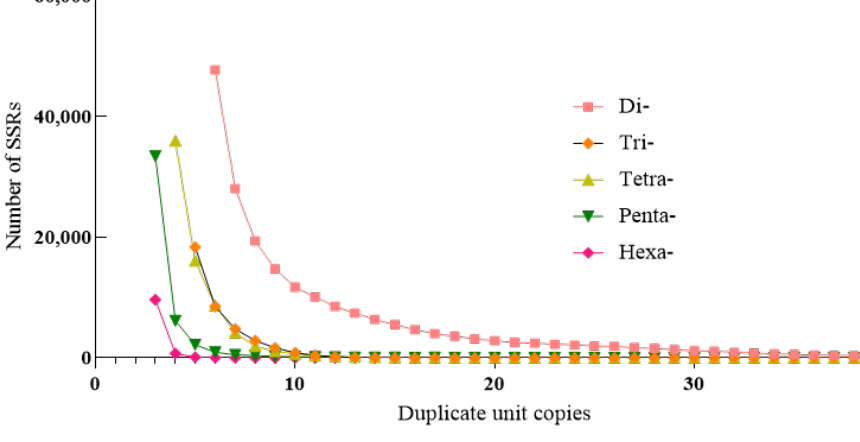
Figure 2. Different copy number distribution of H. molitrix SSRs.